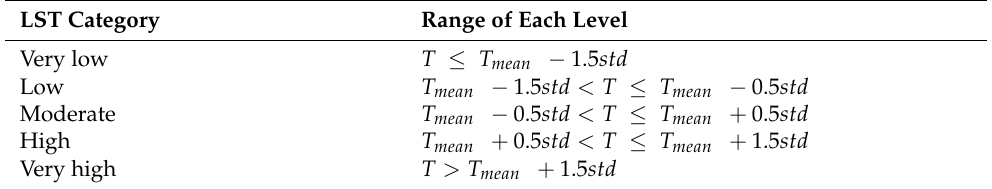
Table 3. Five categories of LST